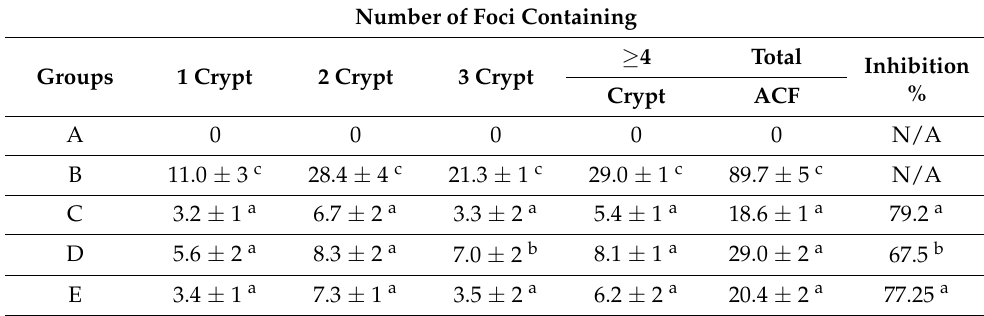
Table 3. Inhibition potentials of OME on AOM-induced colonic ACF in rats.